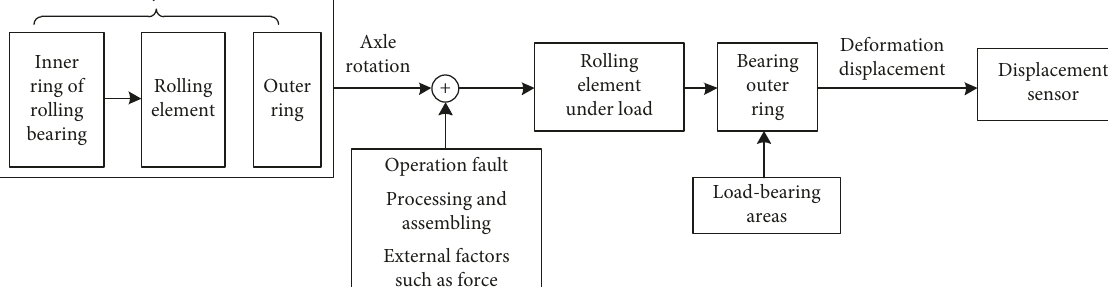
Figure 4: Transfer path of the pickup signal by the high-precision displacement sensor.